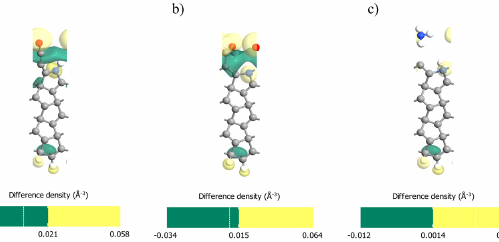
Figure 5: The electron density difference for CO, CO 2 and NH 3 -adsorbed N:SSPGNR. The isosurface value is taken as 0.009 eV ˚A − 3 . The electron density differ- ence is defined as the valence electron density minus the neutral atom electron density.